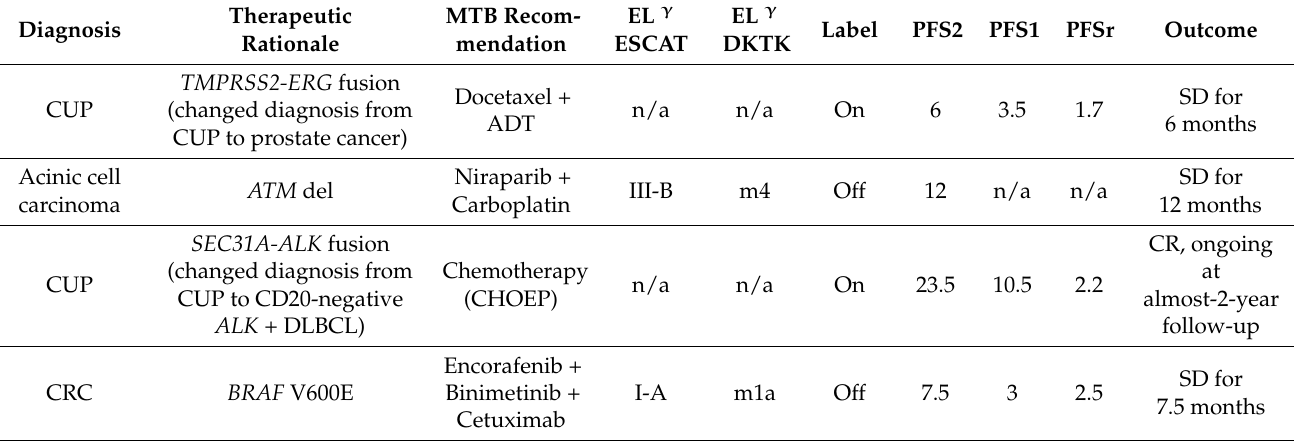
Table 3. Patients with major clinical benefit following MTB recommended